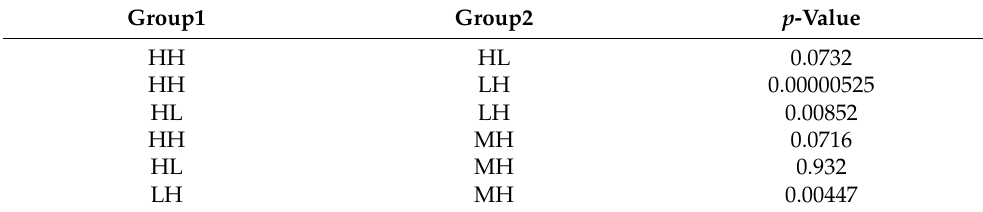
Figure 6. Relationship between the Stage 3 average leaf disc spectra (predicted first principal com- ponent) and C:N ratio. component) and C:N ratio. Table 3. C:N ratio t -test results by treatment